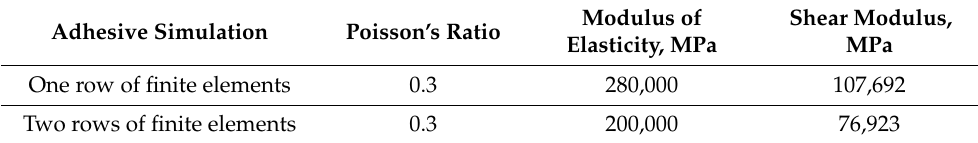
Table 7. Mechanical characteristics of the adhesive.